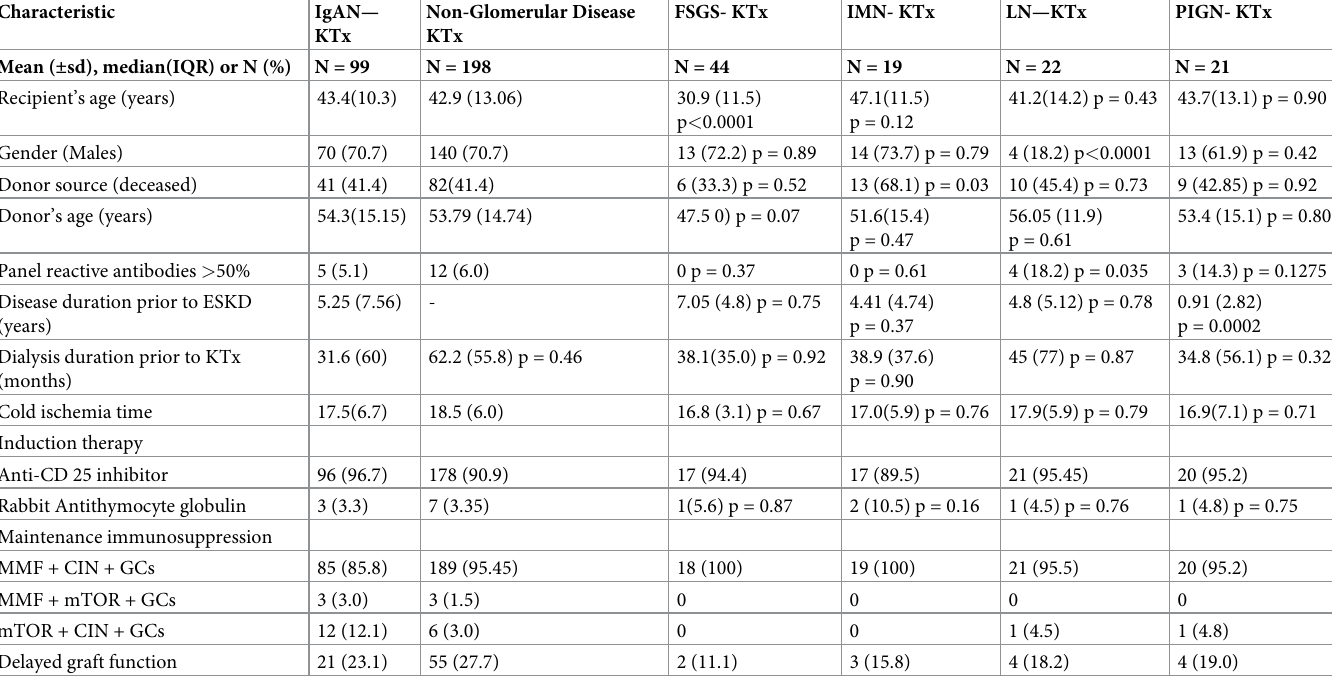
Table 1. Comparison of baseline characteristics of KTx recipients with IgAN as primary disease versus all other groups of controls with primary FSGS, IMN, LN, and PIGN. Characteristic IgAN— Non-Glomerular Disease FSGS- KTx IMN- KTx KTx KTx